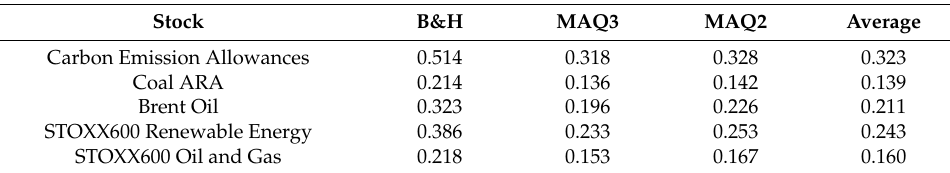
Table A13. Annualized daily (every fourth month) volatility of MAQ2–MAQ3 (Q = every fourth month, and 3, 2, are the numbers of observations in the rolling window), average annualized volatility.